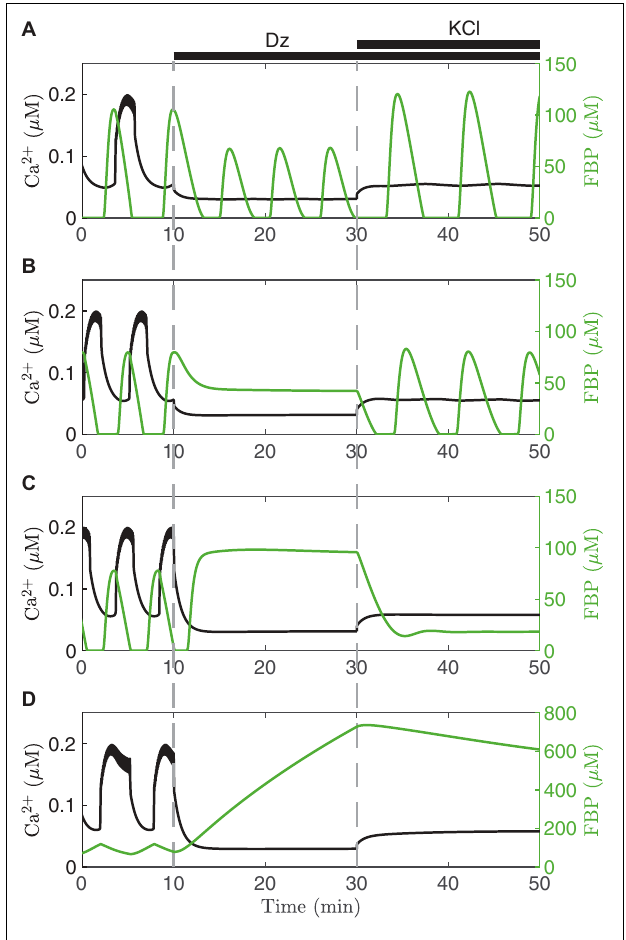
FIGURE 5 | Model simulations in which the membrane potential is clamped with diazoxide (Dz) and elevated KCl. Each panel illustrates the model predictions for v PDH = 7 µ M / ms (A) , 3 µ M / ms (B) , 2 µ M / ms (C) , 0.4 µ M / ms (D) . In all cases, g K ( Ca ) = 150 pS and the glucose concentration is 11 mM.